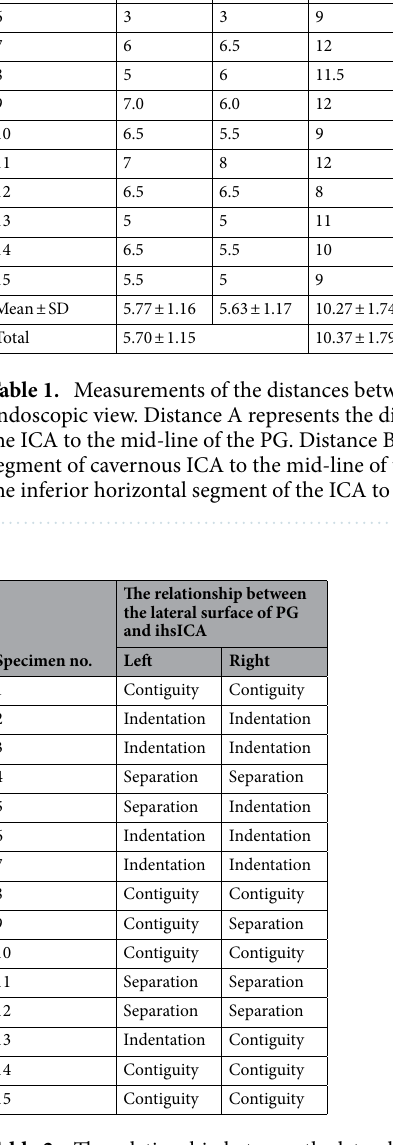
Table 2. The relationship between the lateral surface of the pituitary gland (PG) and the inferior horizontal segments of the internal carotid artery (ihsICA).